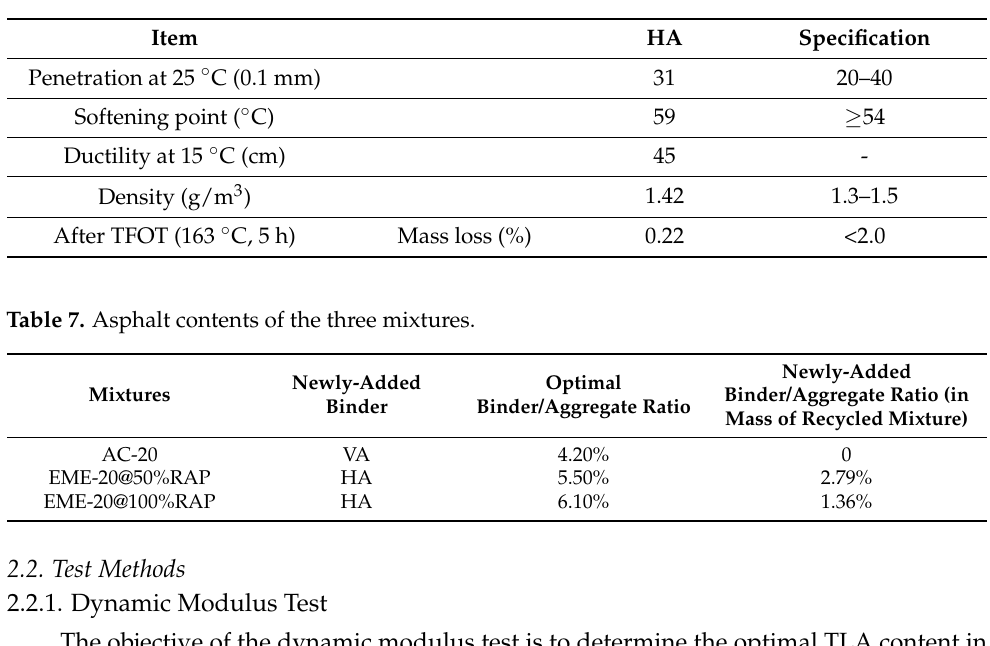
Figure 2. Gradation of the aggregates in the three RAP classifications. Table 5. Physical properties of the aggregates tested according to JTG E42—2005. Table 6. Typical characteristics of used hard asphalt binder.